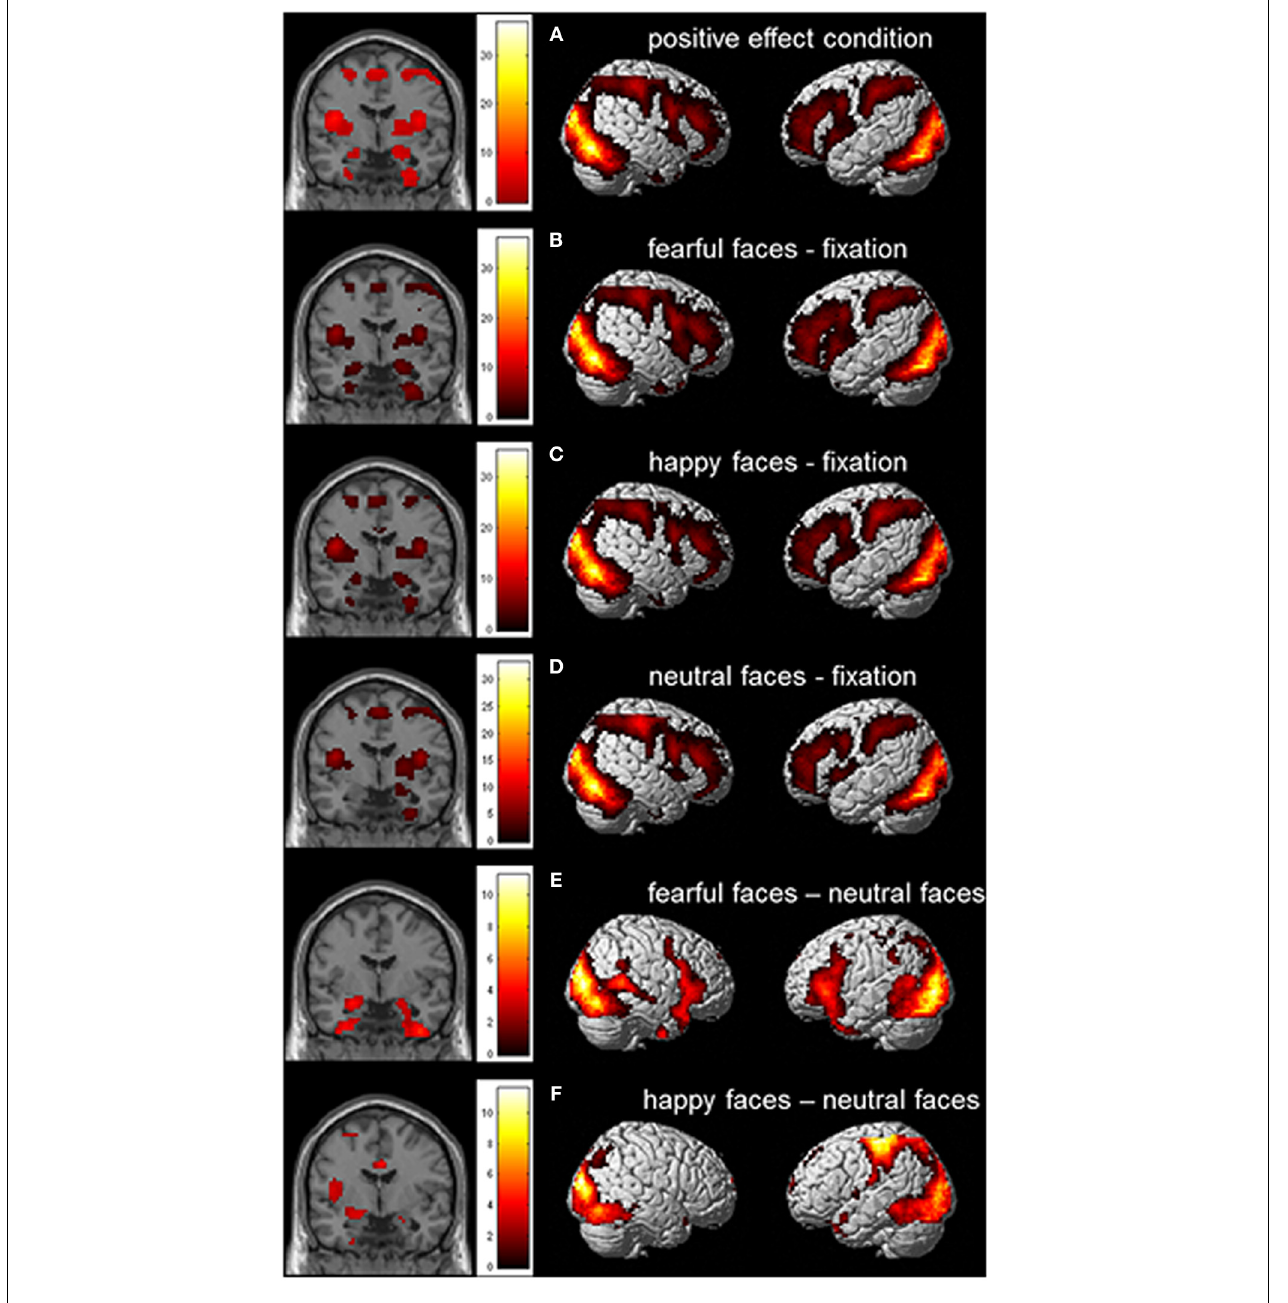
FIGURE 3 | Whole brain contrast showing effects for (A) positive effect of condition; (B) fearful faces > fixation; (C) happy faces > fixation; (D) neutral faces > fixation; (E) fearful faces > neutral